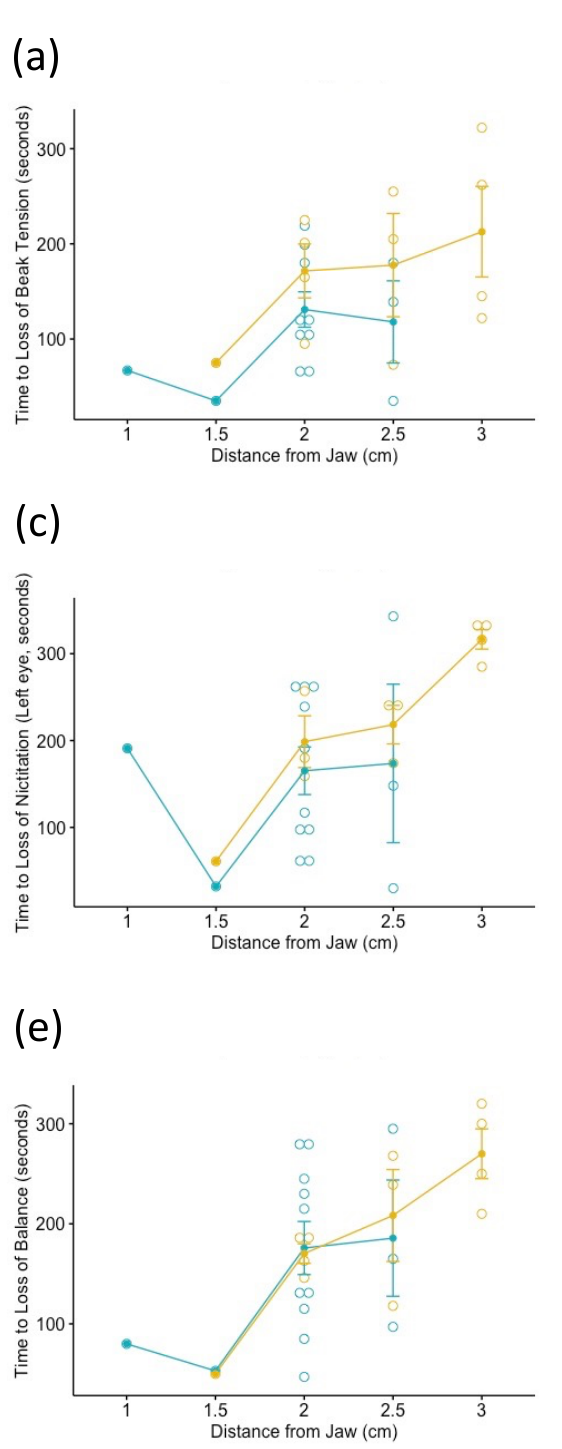
Figure 1. Relationship between distance from right jawbone to neck cut (X axis) and the time to loss of a reflex (Y axis), grouped by presence of clotting (yellow = clotting present, blue = clotting not present). Each point represents a data point (bird). The reflexes are as follows: ( a ) Total loss of beak tension, ( b ) total loss of neck tension, loss of ( c ) left and ( d ) right nictitating reflex, and ( e ) loss of balance. None of the results were significant ( p = 0.208, 0.303, 0.398, 0.719, and 0.880, respectively).